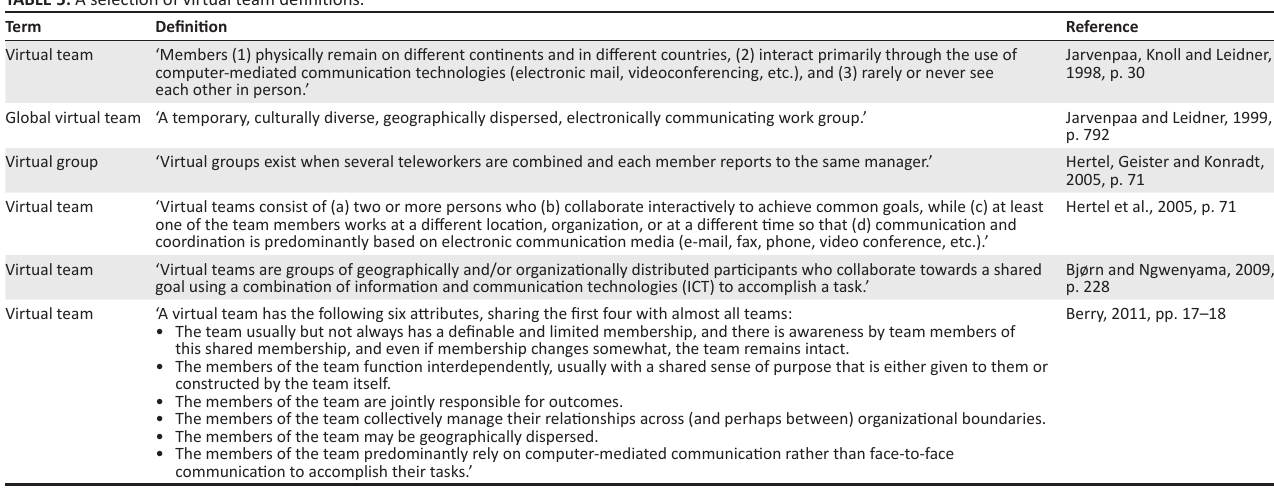
TABLE 5: A selection of virtual team definitions.